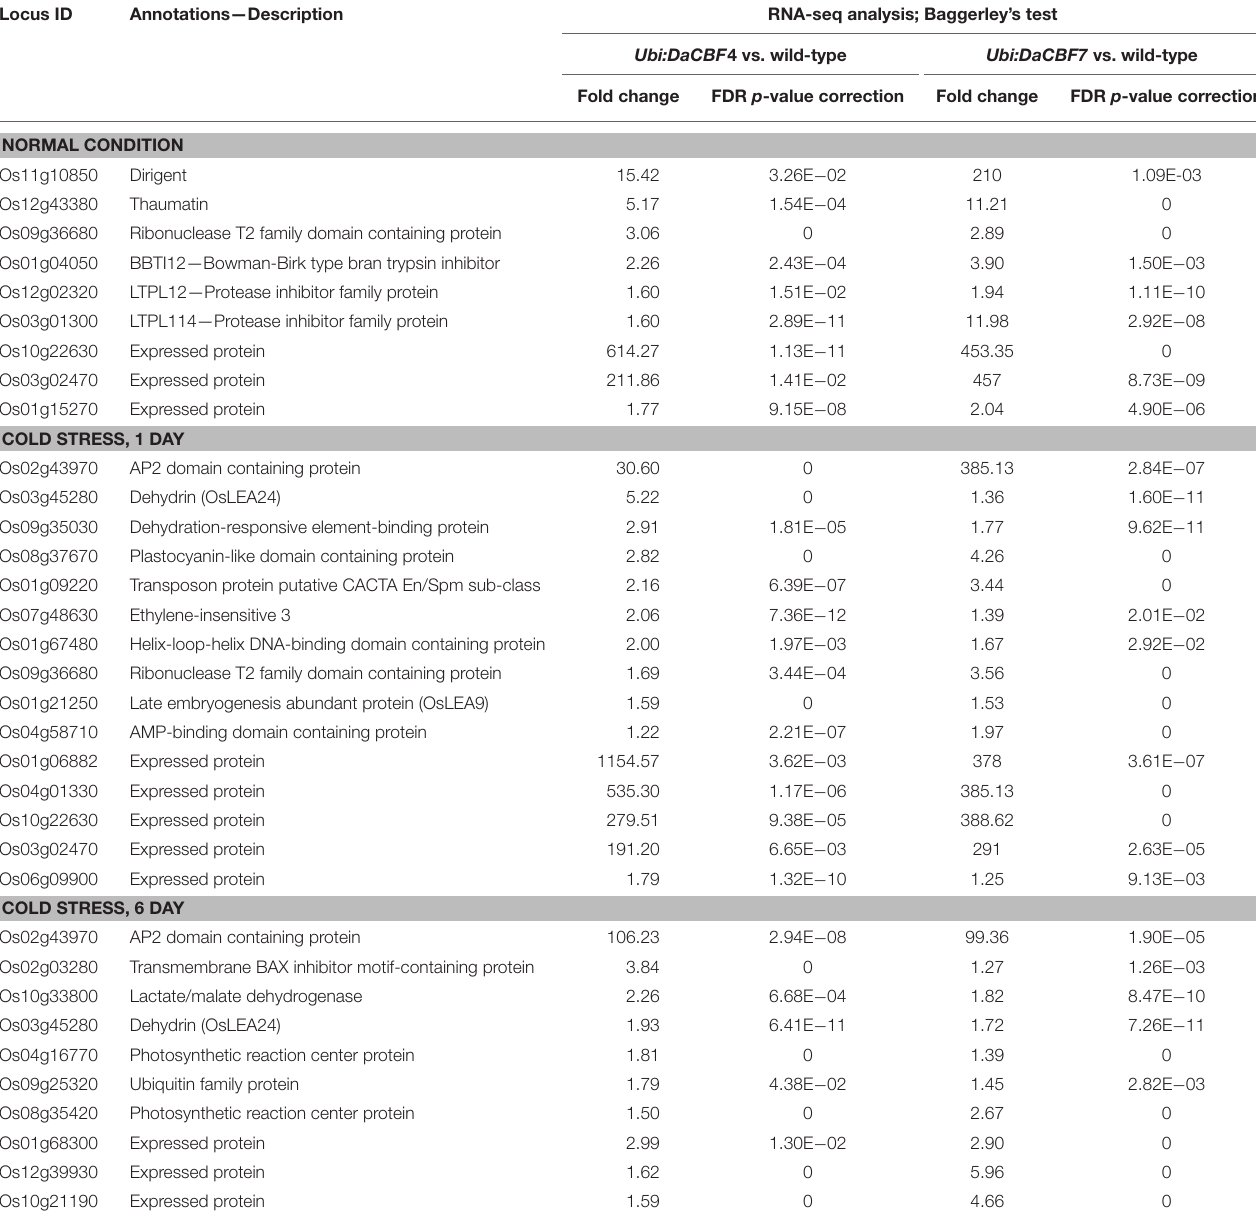
TABLE 1 | List of differentially induced genes in both transgenic rice plants Ubi:DaCBF4 and Ubi:DaCBF7 under normal control or cold stress conditions when compared to wild type plants. Locus